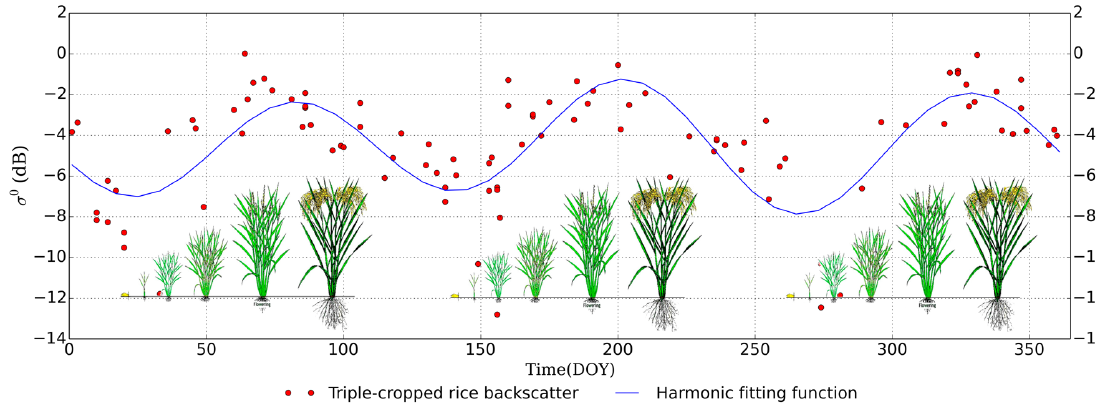
Figure 1. SAR backscatter behavior in relation to rice-growing stages (adapted from [18], growing stage images from [28]) for triple-cropped rice based on a multi-year ASAR WSM time series.